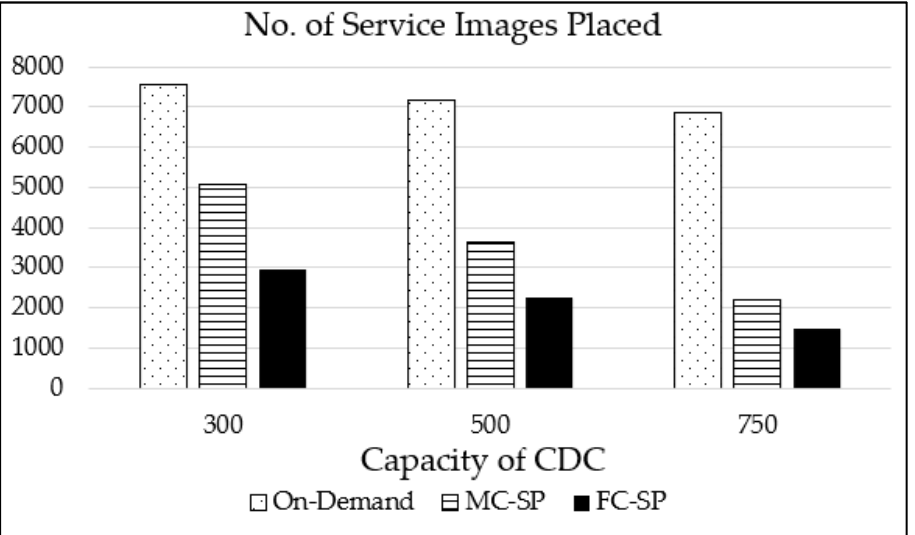
Figure 8. The number of service image placements for various maximum cloud data centers (CDCs) capacities with 1000 service types for the L distribution case.